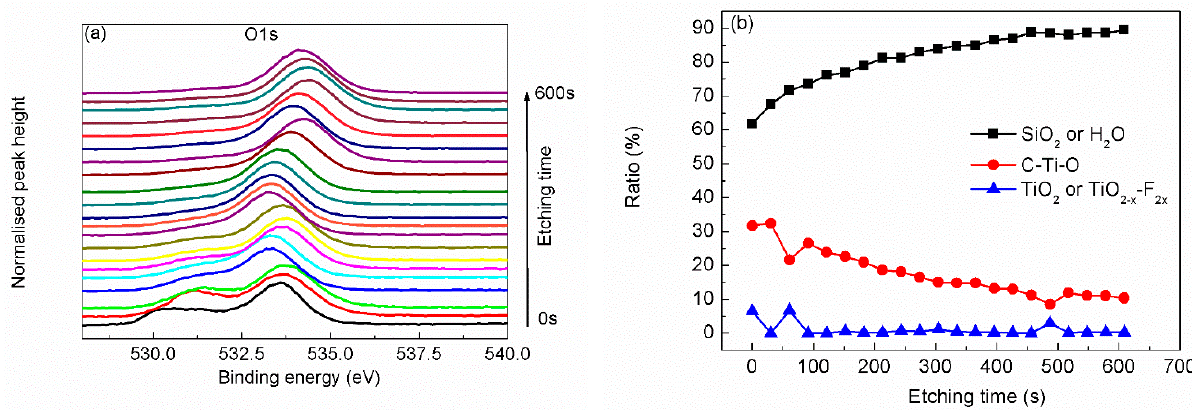
Figure 6. Narrow scanning depth profile ( a ) and state ratio depth profile ( b ) of O 1s.